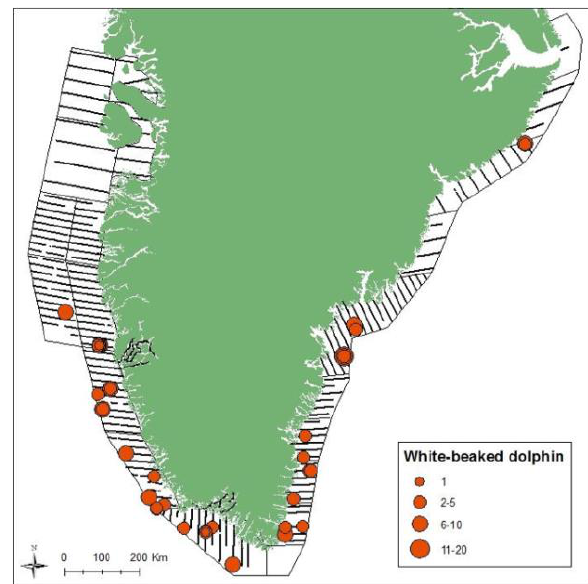
Figure 13. Survey effort in sea states <5 and sightings with group sizes of white-beaked dolphins in East and West Greenland. The expected group size was 4.2 (CV=0.19) in West Greenland and 4.5 (0.19) in East Greenland. A half-normal key with sea state as a variable in the DS component was chosen for the MRDS model (Figure 14) and that provided at-surface abundance estimates of 2,747 white-beaked dolphins (95% CI: 1,257-6,002) in West Greenland and 2,140 (95% CI: 825-5,547) in East Greenland with a joint perception bias of 0.99 (CV=0.01) (Table